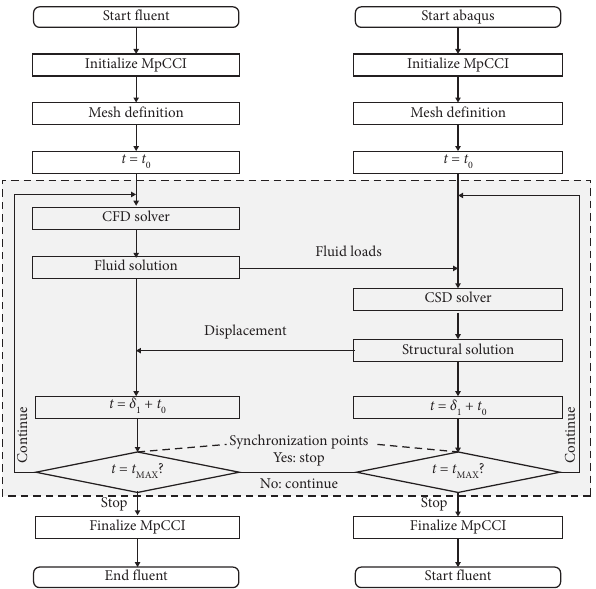
Figure 9: The fluid-structure coupling